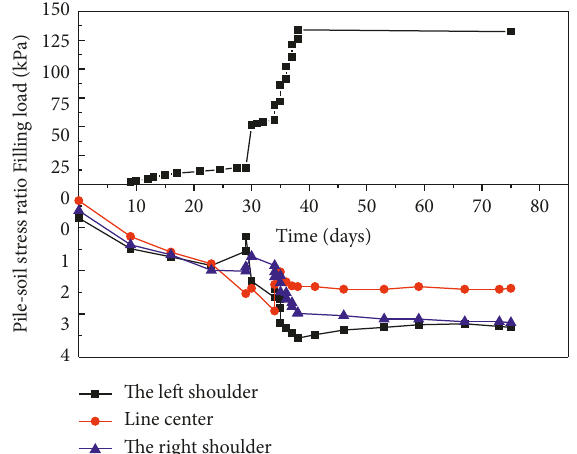
Figure 6: Relationship between the foundation coefficient K and settlement δ s /( s - d ) between the piles and soil.